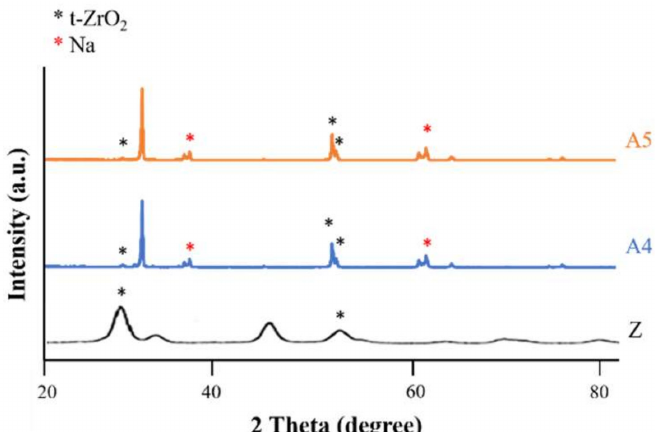
Figure 5. Use of XRD analysis for comparing untreated zirconia (Z) and alkaline treatments with different concentrations of A4 and